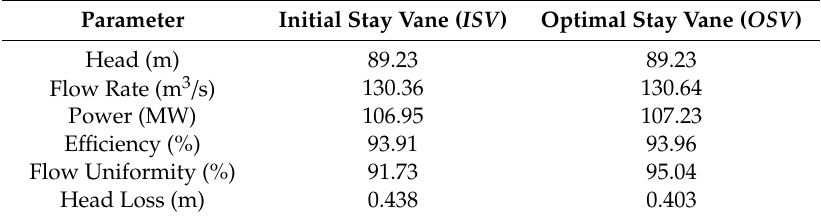
Figure 15. Comparison of initial and optimal stay vane designs for the 100 MW class Francis turbine. Table 9. Results of stay vane optimization for the 100 MW class Francis turbine. Parameter Initial Stay Vane ( ISV